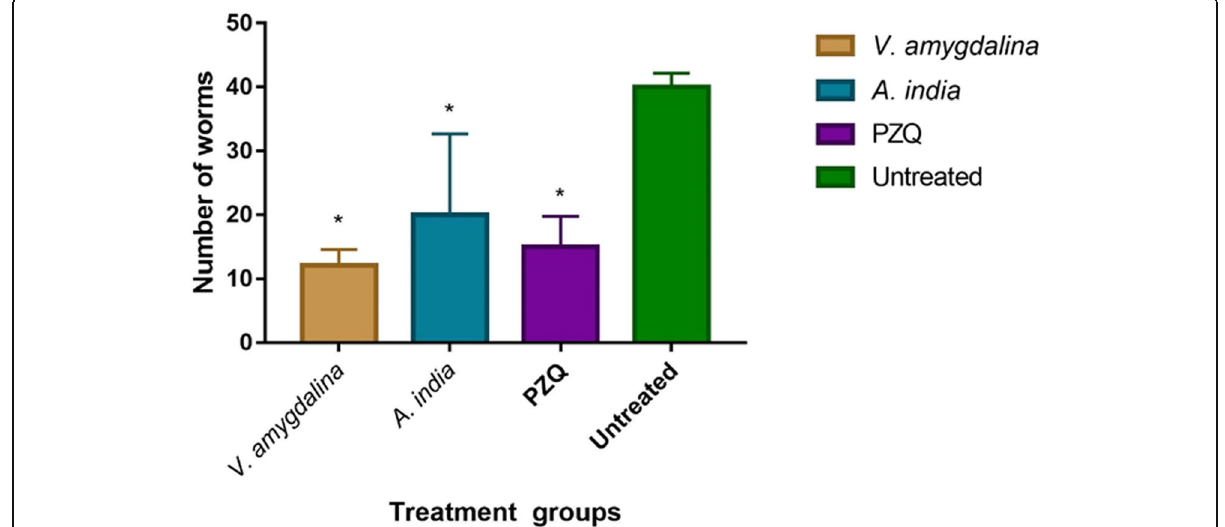
Fig. 3 Mean worms recovered from treatment groups. The number of worms after treatment with the different extracts and PZQ. All treatment group compared with the untreated at p = 0.05 statistical